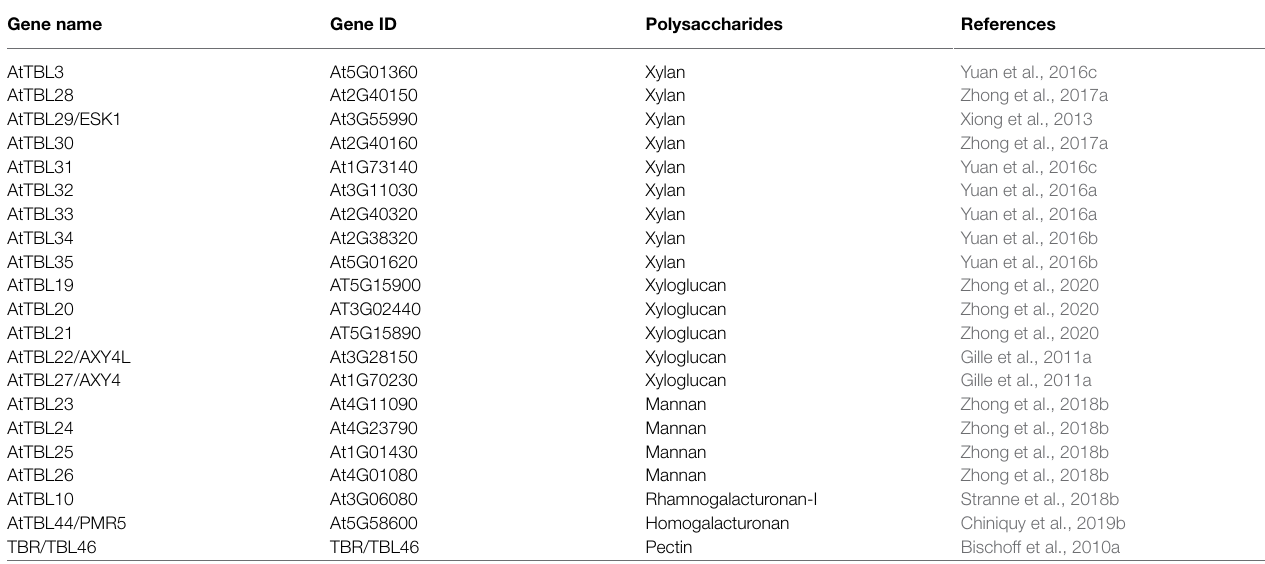
FIGURE 3 | Phylogenetic analyses of TBL protein family in rose with Arabidopsis thaliana TBL protein family. Genes marked with pink have been shown to be involved in O -acetylation of cell wall polysaccharides in A. thaliana ( Table 3 ); genes marked with green may be involved in the defense of roses against B. cinerea and were knocked down by virus-induced gene silencing (VIGS) in rose petals. Arrows refer to the well-known TBL proteins in Arabidopsis. The bootstrap values are indicated on the nodes of the branches. TABLE 3 | Arabidopsis TBL family genes involved in